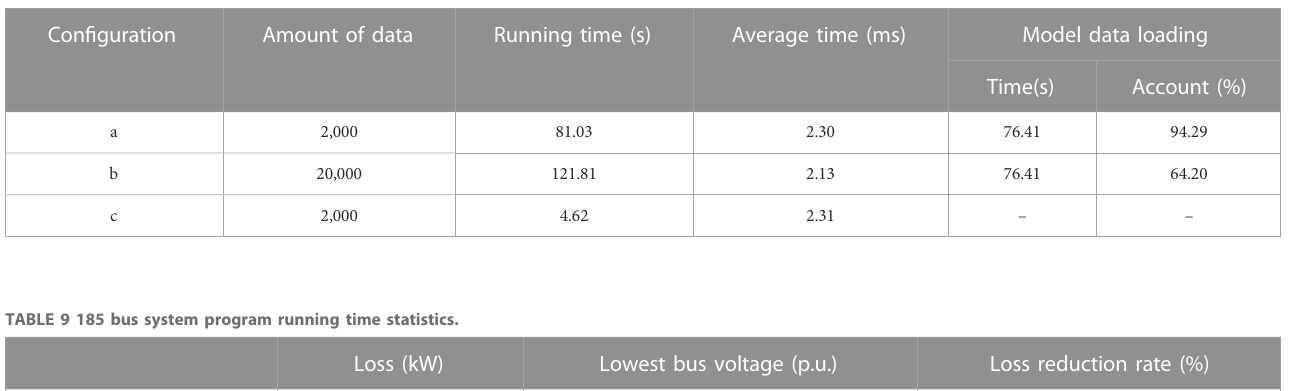
TABLE 8 185 bus system program running result.